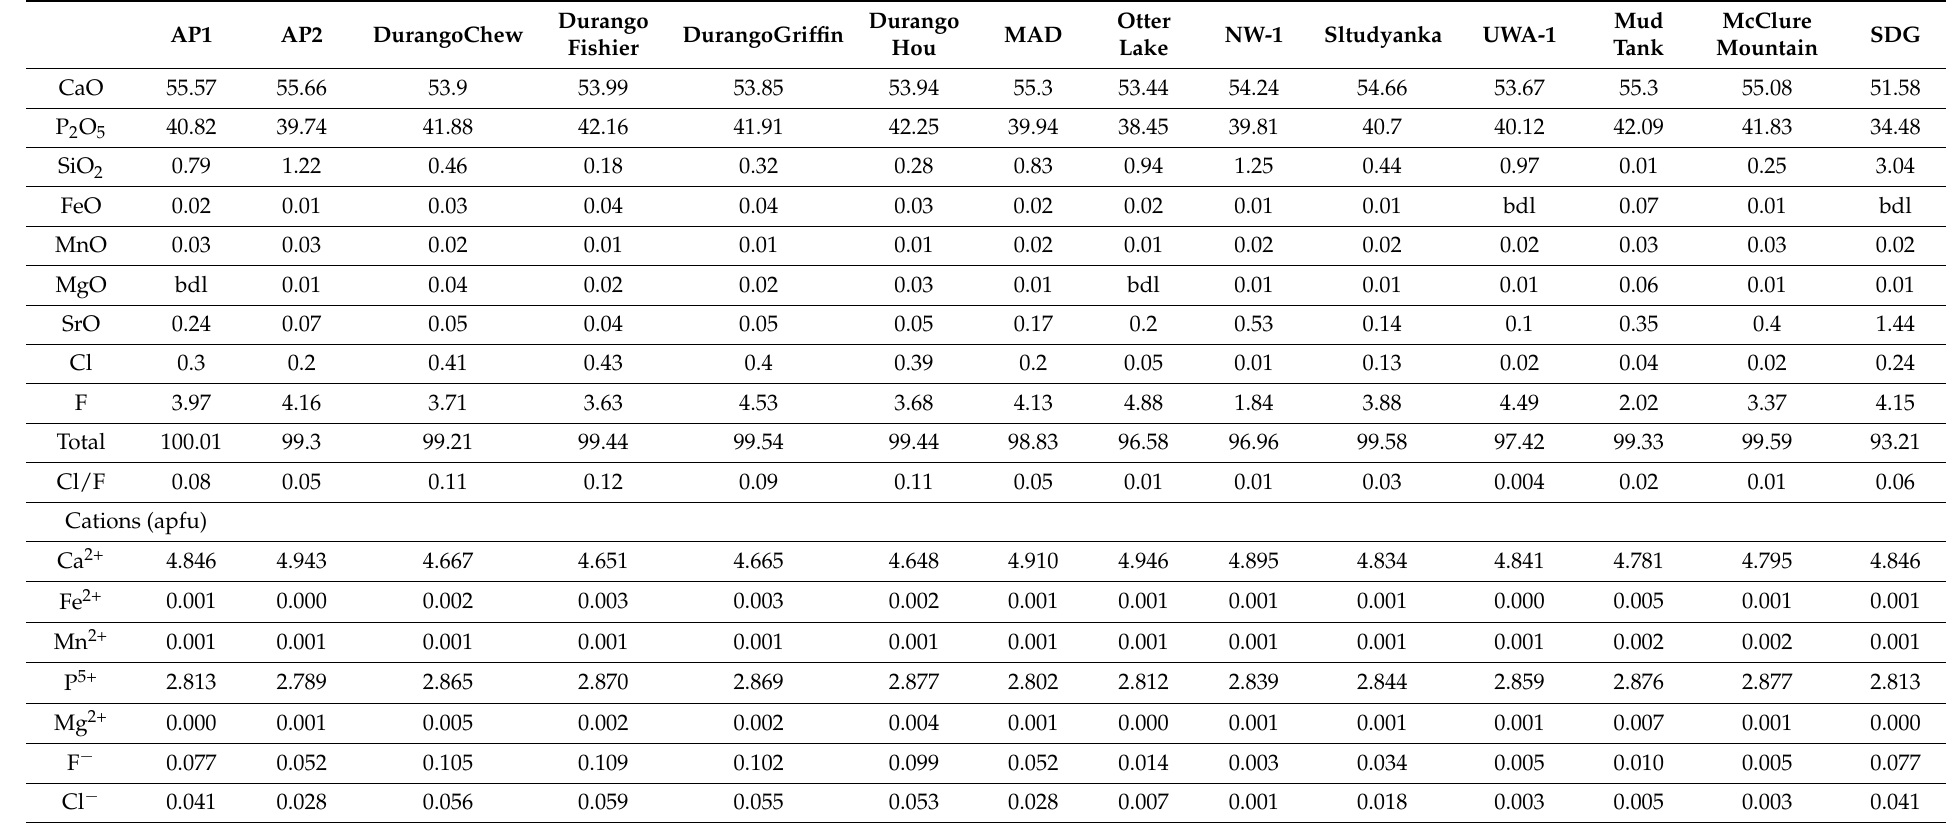
Table 2. Chemical composition and structural formula of apatite from other origins, analysed by EMPA (in wt %). Data derived from